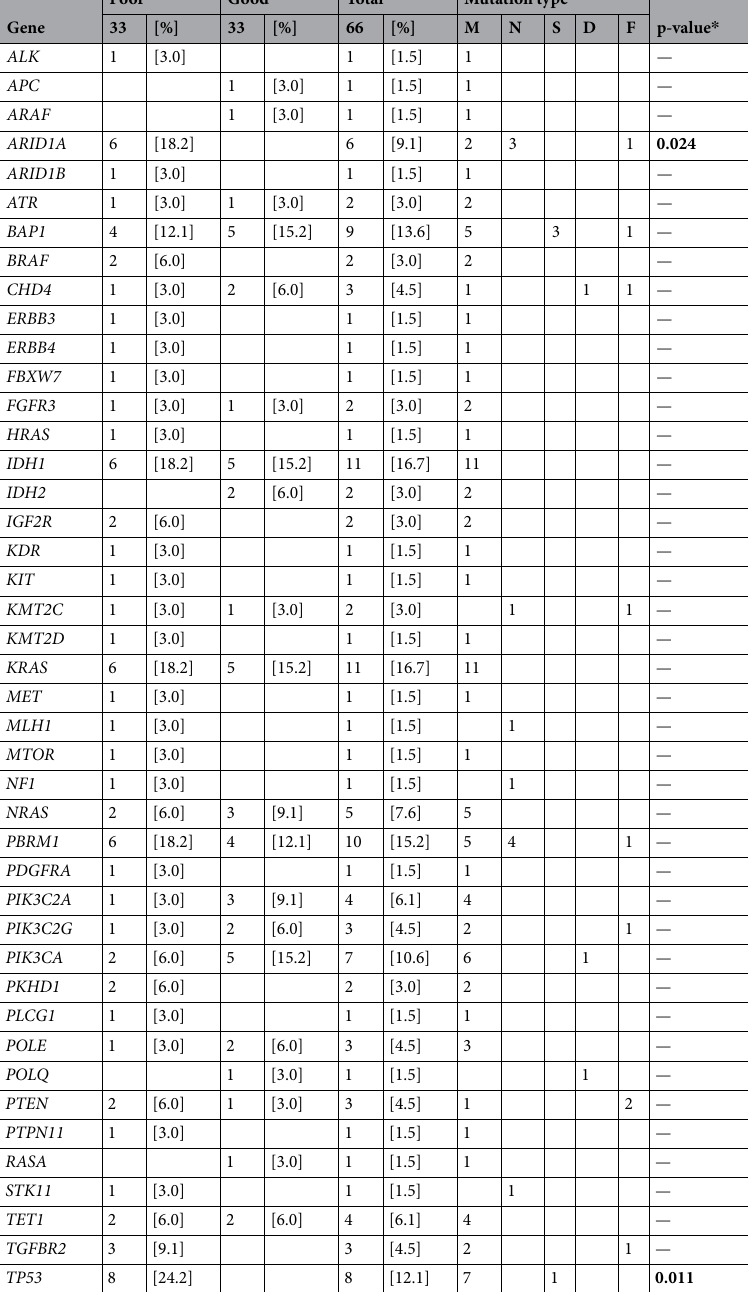
Table 2. Detailed mutational prevalence analysis of 66 intrahepatic cholangiocarcinomas. Related to Fig. 2. Note: M. missense; N. nonsense; S. splite site alteration; D. deletion; F. frameshift. * Fisher test for multiple comparison was used as